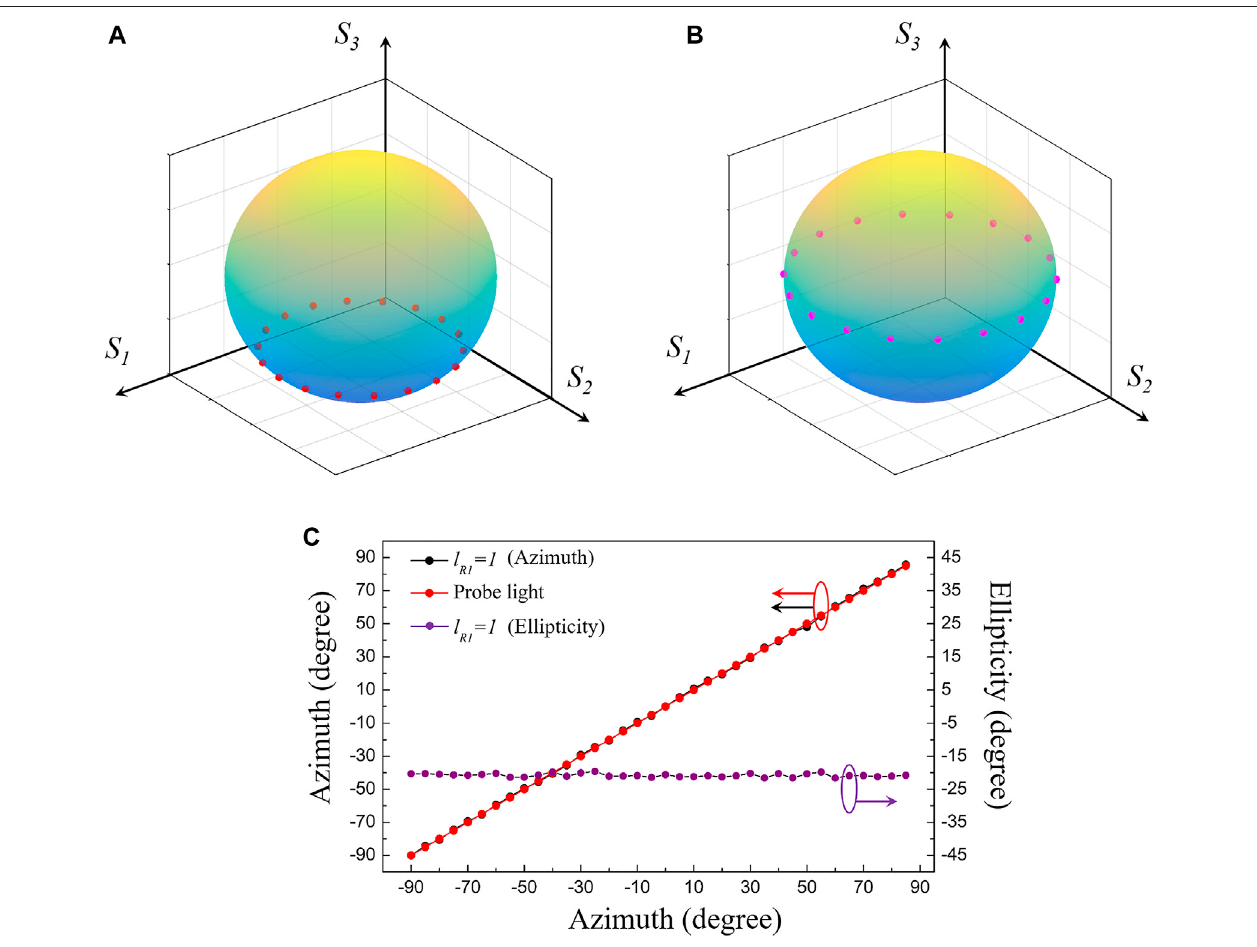
FIGURE 3 | (A) Orbital-to-spin AM manipulation through OPHG ( l R1 = 1) presented on the Poincaré sphere. S 1 - S 3 are normalized Stokes parameters. (B) UnmodulatedpolarizationstatesofthezerothdiffractionorderfromPHGrecordedthroughtheholographiclight fi eldwithoutspatialdegreeoffreedomasacomparison. (C) The azimuth of the elliptically polarized zeroth-order diffraction light from OPHG ( l R1 = 1) is not regulated by OAM and remains the same with that of the probe light. Moreover, the value of ellipticity almost keeps constant as the polarization direction of the probe light rotates at an interval of 5 ° .